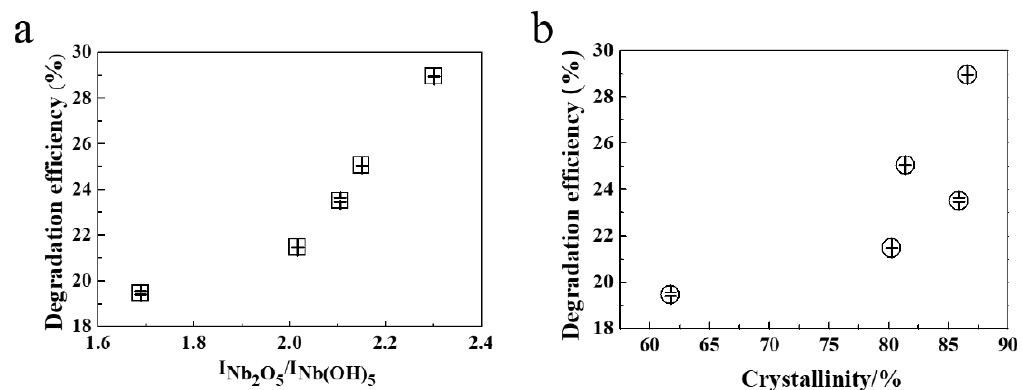
Figure 8. Effect of ( a ) composition and ( b ) crystallinity of Nb 2 O 5 NA samples on degradation efficiency.